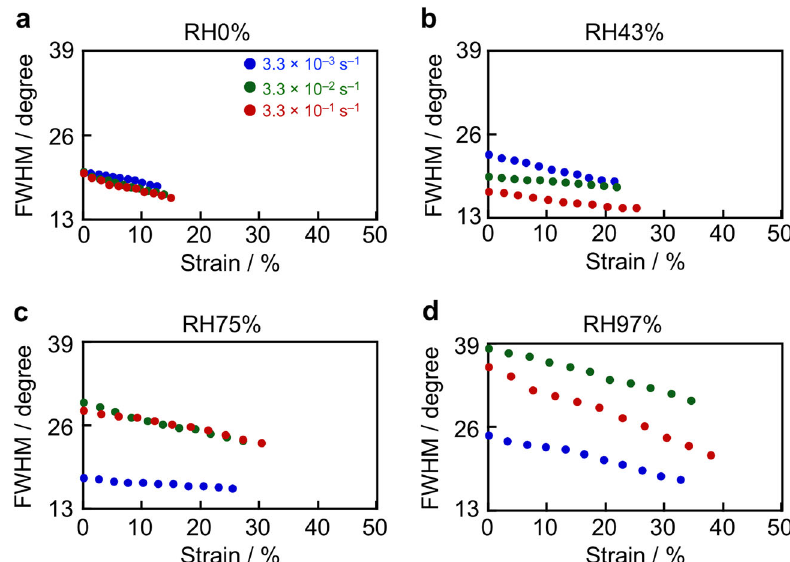
Fig. 9 FWHM of the spider dragline silk fi ber as a function of strain under different strain rates. FWHM calculated from the azimuthal intensity WAXS pro fi les of the radially integrated (210) peak in the simultaneous WAXS-tensile test under different RHs: a RH0%, b RH43%, c RH75%, and d RH97%. The blue, green, and red dots denote strain rates of 3.3 × 10 − 3 s − 1 , 3.3 × 10 − 2 s − 1 , and 3.3 × 10 − 1 s − 1 ,